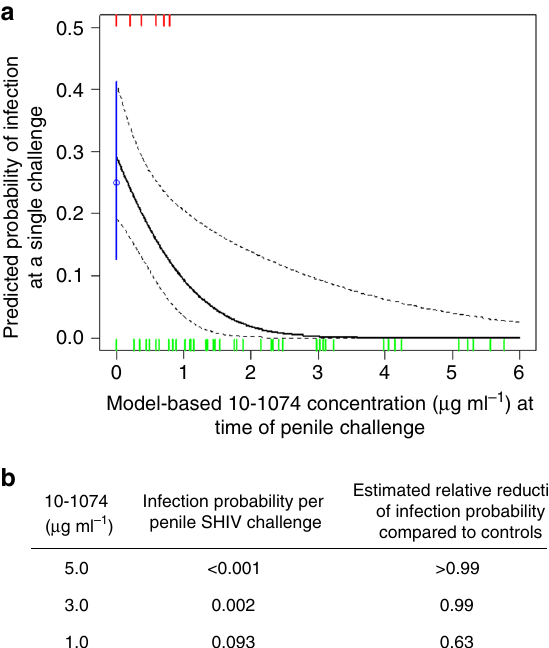
Fig. 2 10 – 1074 antibody concentration predicts the probability of infection following penile SHIV SF162P3 challenge. a Probit regression analysis was used to estimate the per-challenge probability of penile SHIV acquisition as a function of imputed 10 – 1074 concentration in plasma. The per-challenge probability of infection among untreated control animals was 0.25 (95% CI 0.13 – 0.41) and is denoted in blue. Tick marks represent SHIV challenge events that either did (red) or did not (green) result in systemic infection. The solid black line is the model-based prediction; dotted black lines depict 90% pointwise con fi dence intervals. b Model-based estimates of SHIV infection probabilities following a single penile challenge and reduction of infection probability as compared with controls, at the indicated plasma concentrations of 10 –